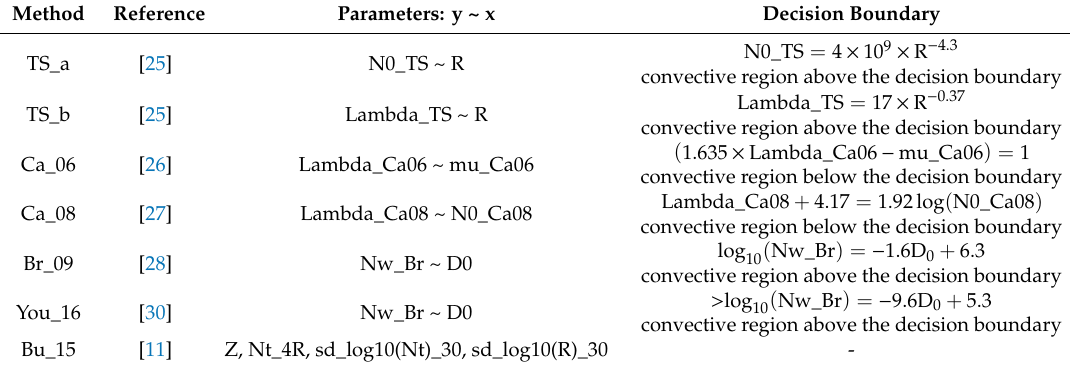
Table 3. Rain type classification methods from the